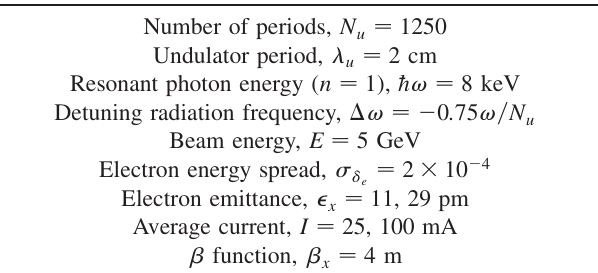
TABLE II. Parameters used in computing the radiation phase space.